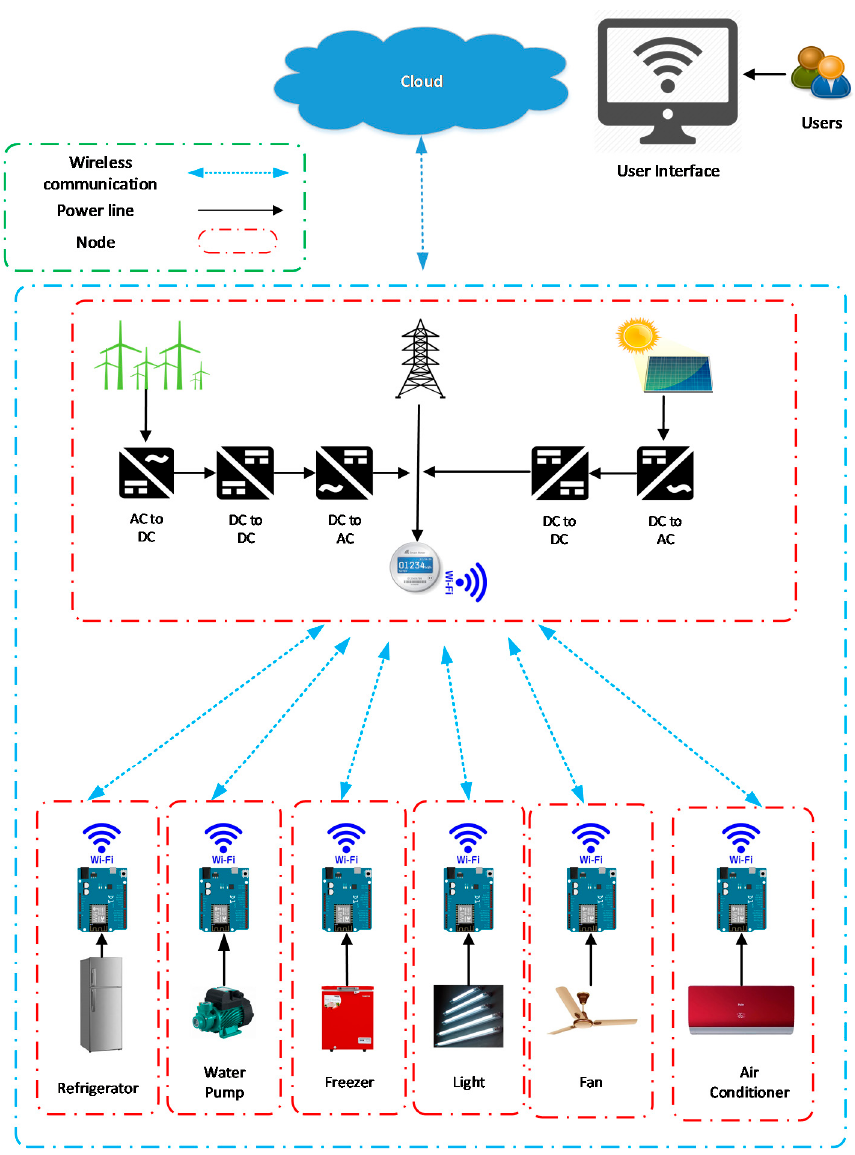
Figure 1. Suggested structure